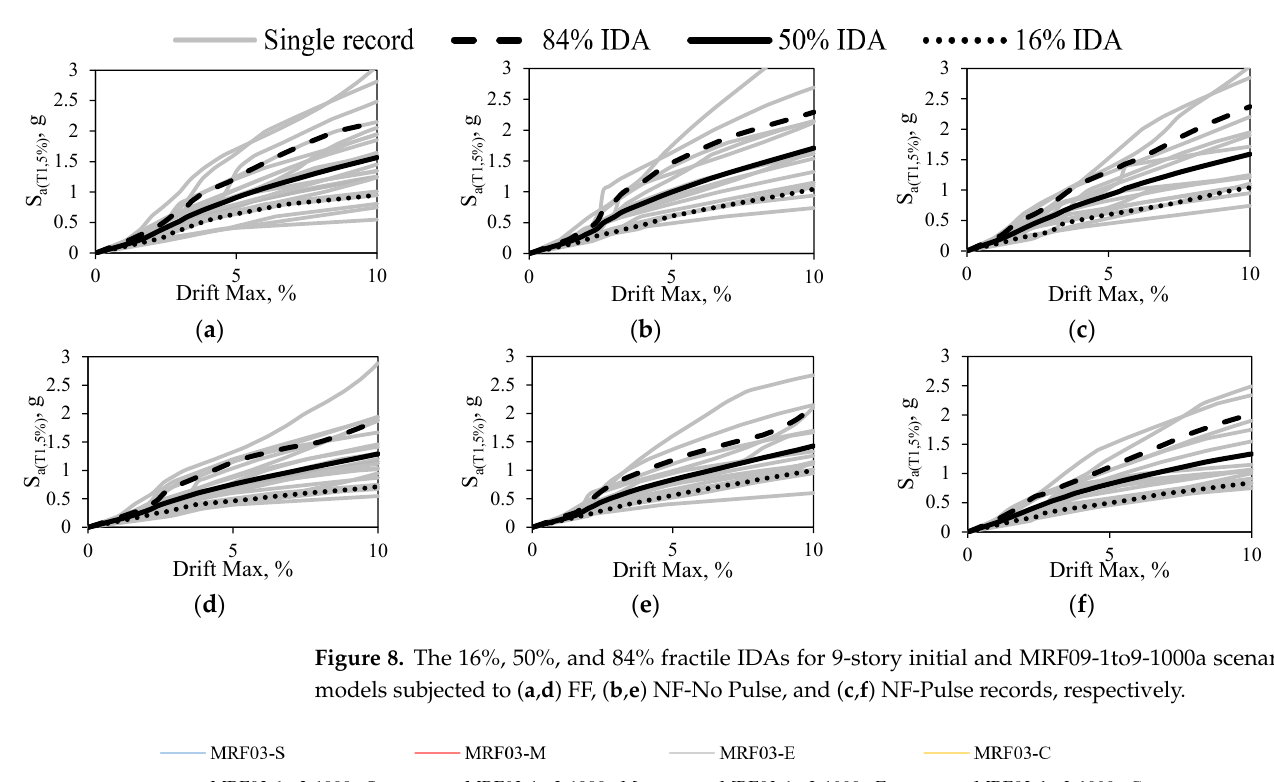
Figure 7. The 16%, 50%, and 84% fractile IDAs for 6-story initial and MRF06-1to6-1000a scenario models subjected to ( a , d ) FF, ( b , e ) NF-No Pulse, and ( c , f ) NF-Pulse records, respectively.